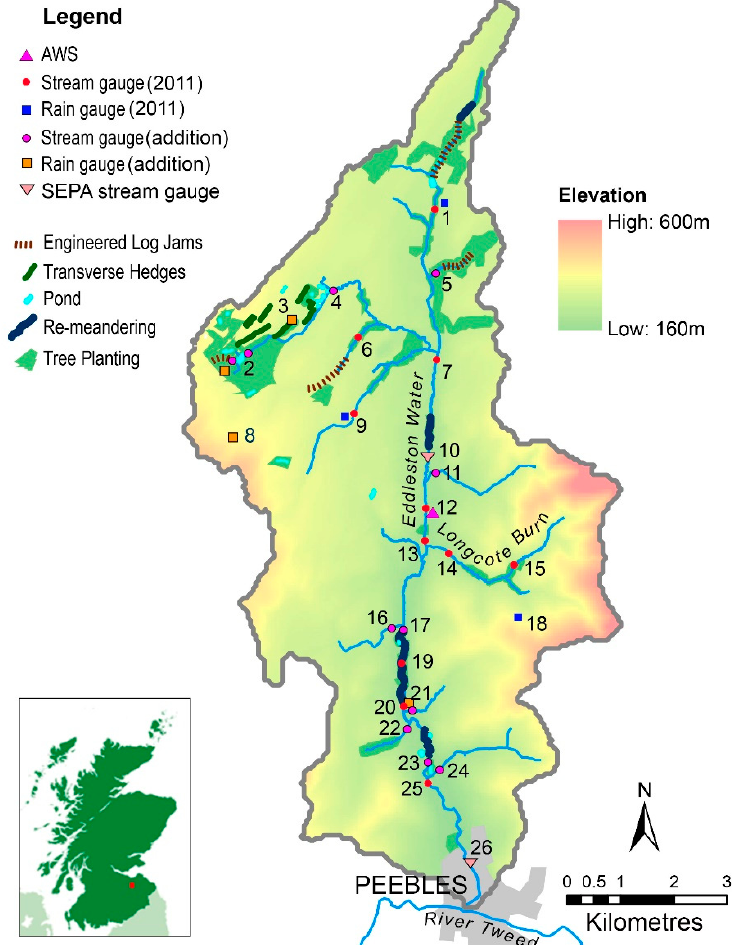
Figure 1. Eddleston catchment map showing location in Scotland (inset), NFM measures and numbered locations of hydrology monitoring instruments: (1) Craigburn, (2) Ruddenleys, (3) Wester Deans, (4) Cowieslinn Burn, (5) Westloch Burn, (6) Middle Burn, (7) Earlyvale, (8) Cloich Forest, (9) Shiplaw Burn, (10) Signal Cottage/Shiphorns/SEPA Shiplaw GS, (11) Harcus Burn, (12) Darnhall, (13) Eddleston Village, (14) School, (15) Middle Longcote, (16) Wormiston Burn, (17) Lake Wood, (18) Burnhead, (19) Cringletie (replaces Milkieston Toll), (20) Nether Kidston, (21) Windylaws Burn, (22) Kidston Burn, (23) Kidston Central, (24) Winkston Burn, (25) Kidston Mill/Rosetta Bridge, (26) SEPA March Street GS.